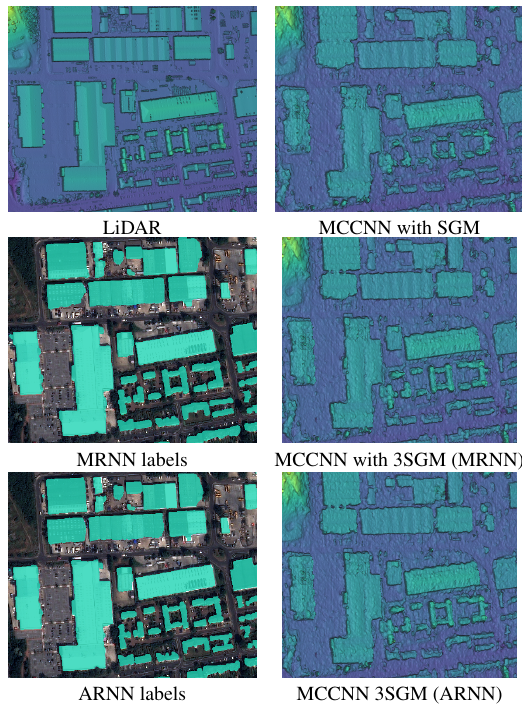
Figure 6. DSMs computed on London (UK) with different optimizations. 3SGM method performs best.